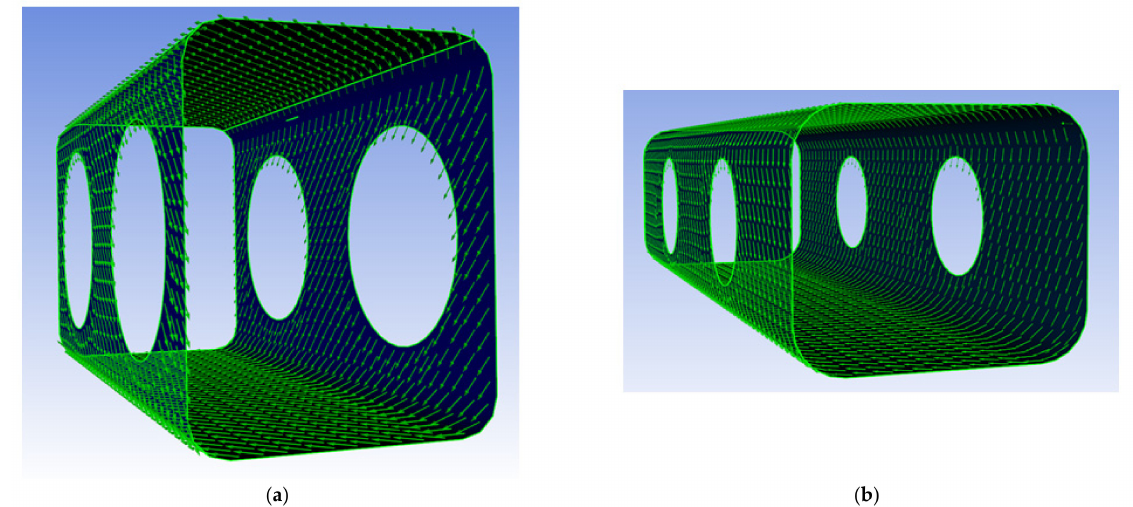
Figure 6. Modeling of fiber winding angle and layer thickness for EW ( a ) and LW tracheids ( b ) in Ansys ACP PrePost.